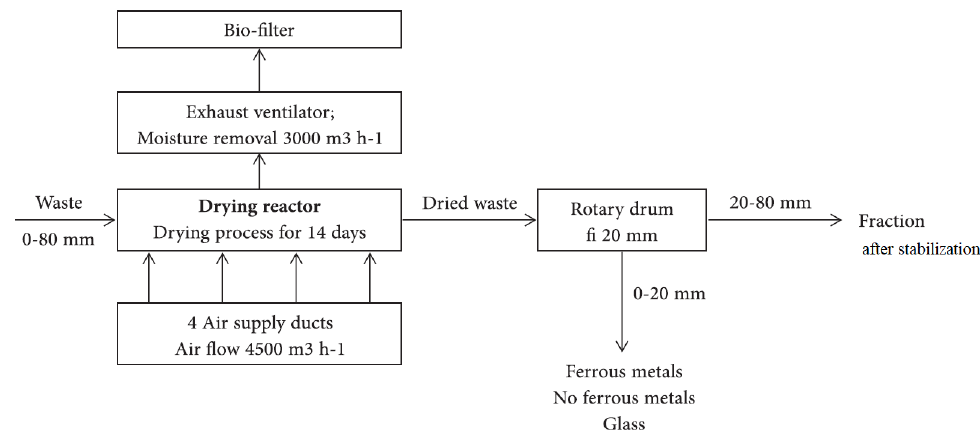
Figure 1. The scheme of the biological stage in the MBT installation.